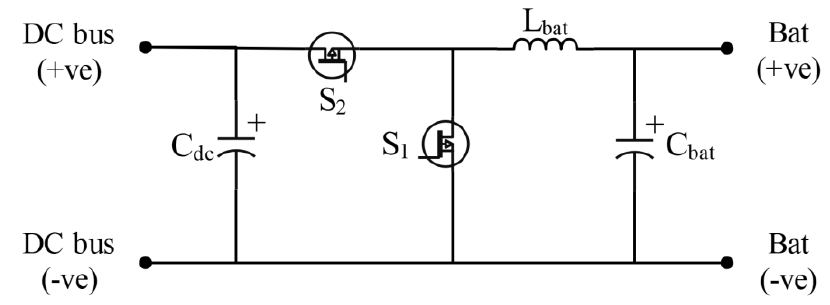
Figure 10. Model of the battery bi-directional boost converter.